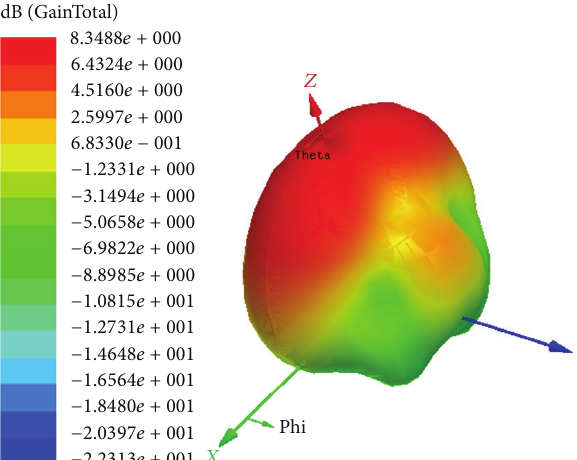
Figure 12: 3D gain pattern at 5.8 GHz.